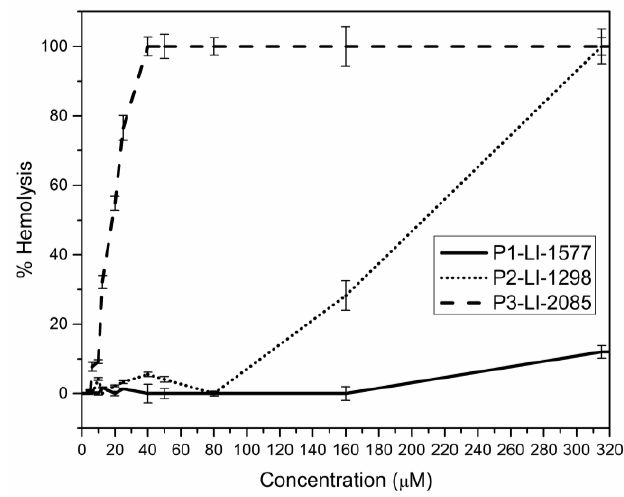
Figure 3. Hemolytic activity of the peptides.